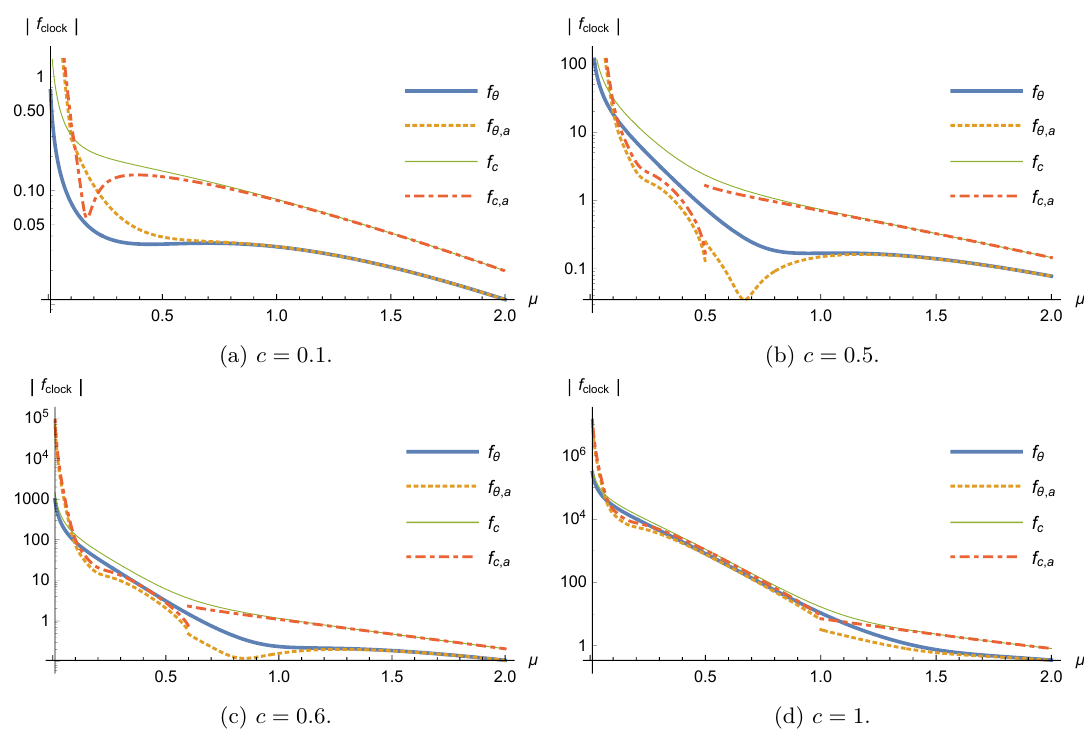
Figure 6. The amplitude of f θ ( µ, c ) and f c ( µ, c ) defined in (4.32) from three point function, for c taking different values. The dashed lines show the approximate functions as shown in (4.34) and (4.35), the discontinuities of which take place around µ = c